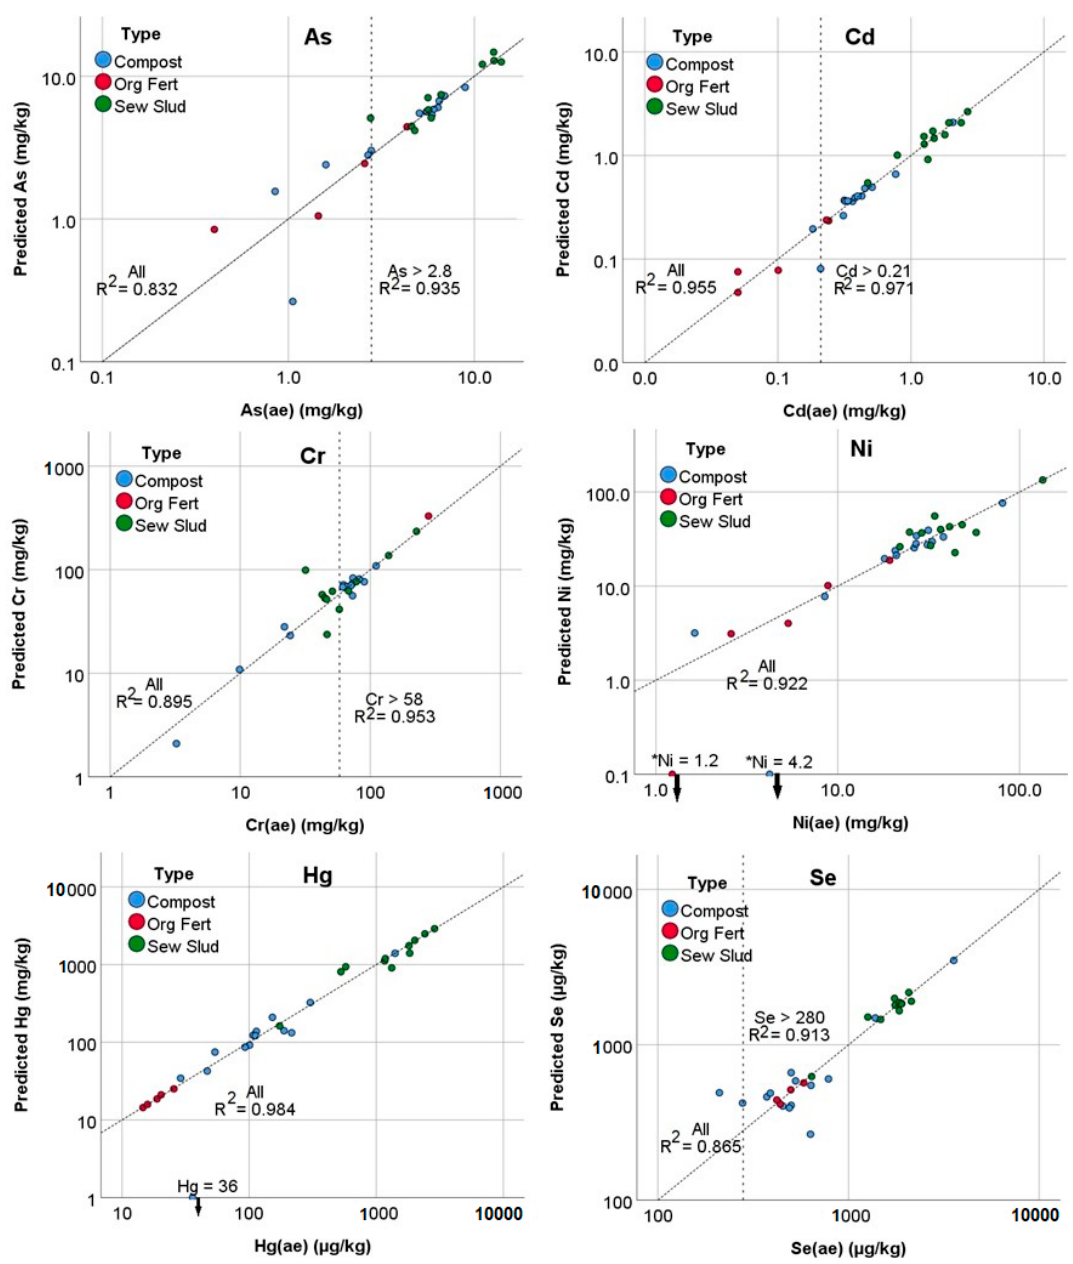
Figure 3. Predicted values for each element obtained for each type of amendment with the equations in Tables 3–5 against each corresponding aqua regia concentration.